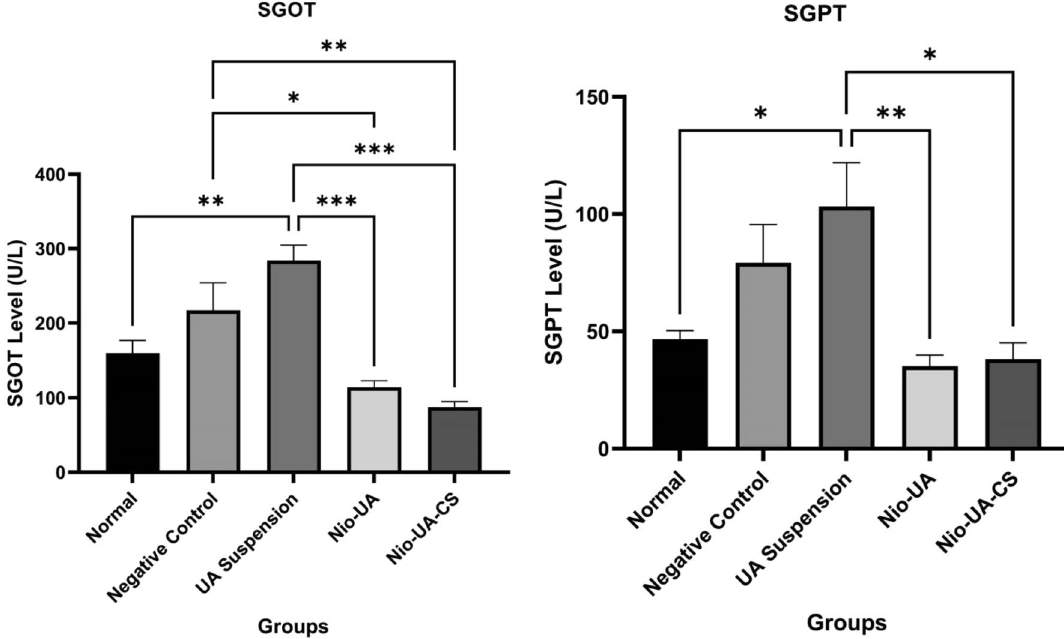
Figure 5. Graph of the average SGOT and SGPT levels in the normal group and the NDEA-induced group at a dose of 25 mg/kgBW with suspension UA, Nio-UA, and Nio-UA-CS treatments which were equivalent to 11 mg UA/kgBW. The data displayed is the mean ± SD (n =